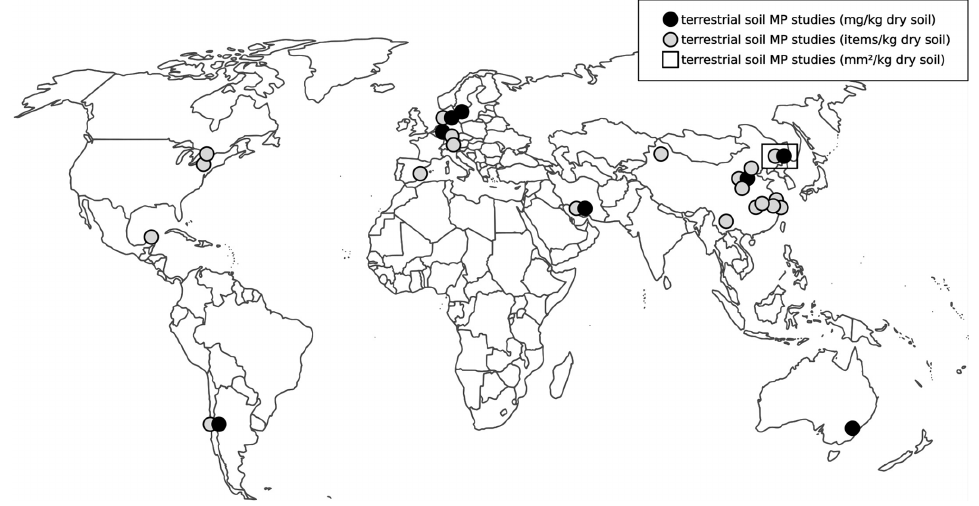
Figure 2. Global distribution of studies on soil microplastic concentrations (status – August 2020).